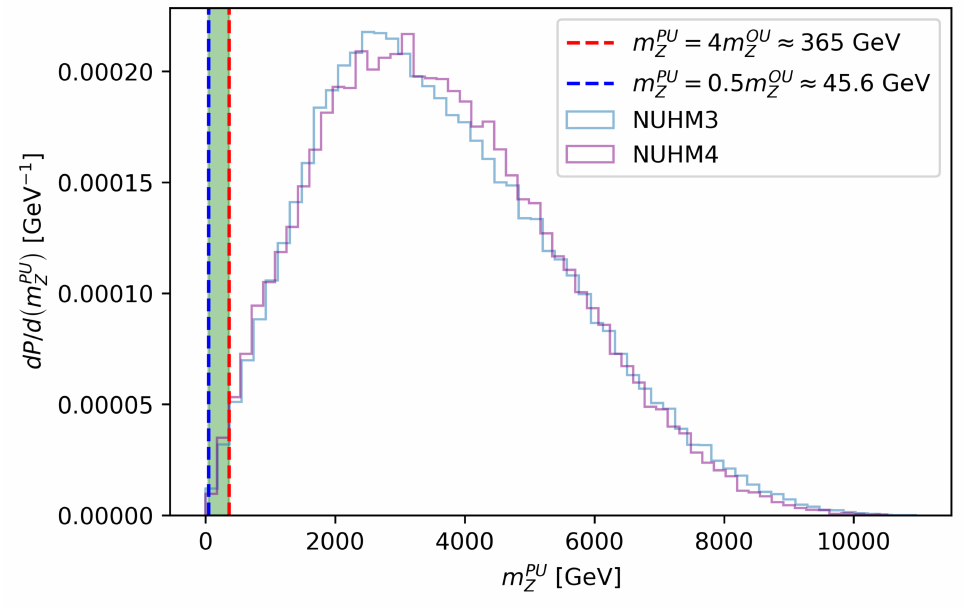
Figure 1. The predicted value of m PU doesn’t fine-tune parameters to fix m PU